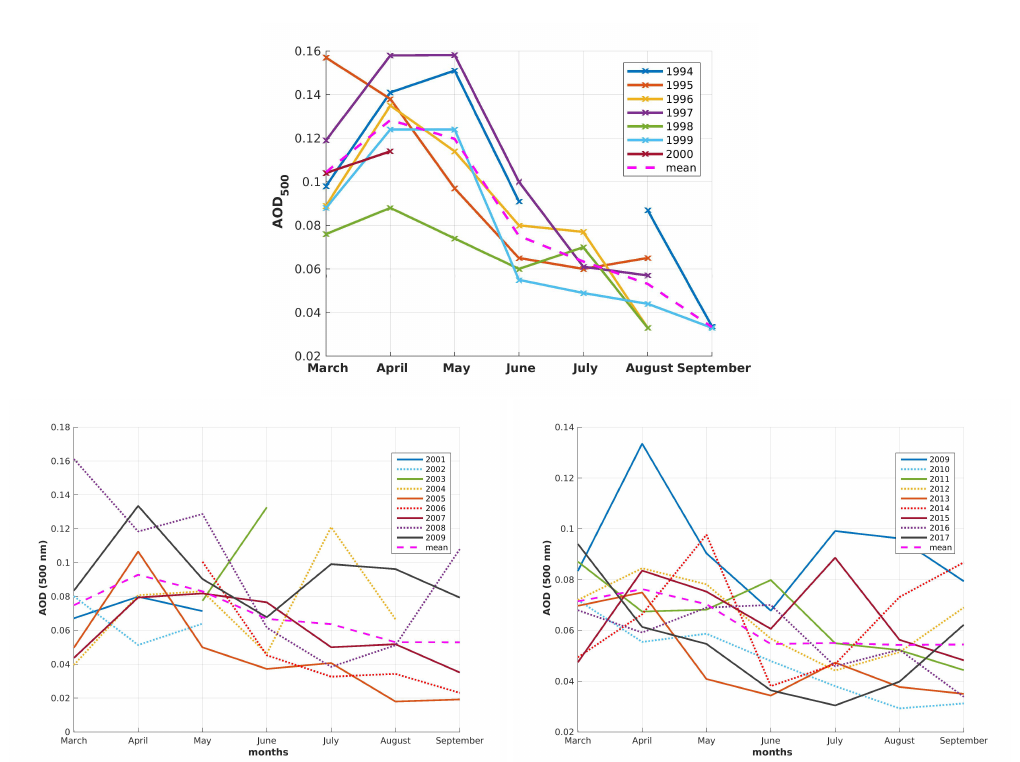
Figure 6. Monthly means in AOD for the years 1994–2000 (first row), 2001–2009 (bottom, left), and 2009–2017 (bottom, right). The dashed magenta lines are the monthly means of the corresponding time interval. Note that the year 2009 is plotted as well in both plots (bottom) as a reference.